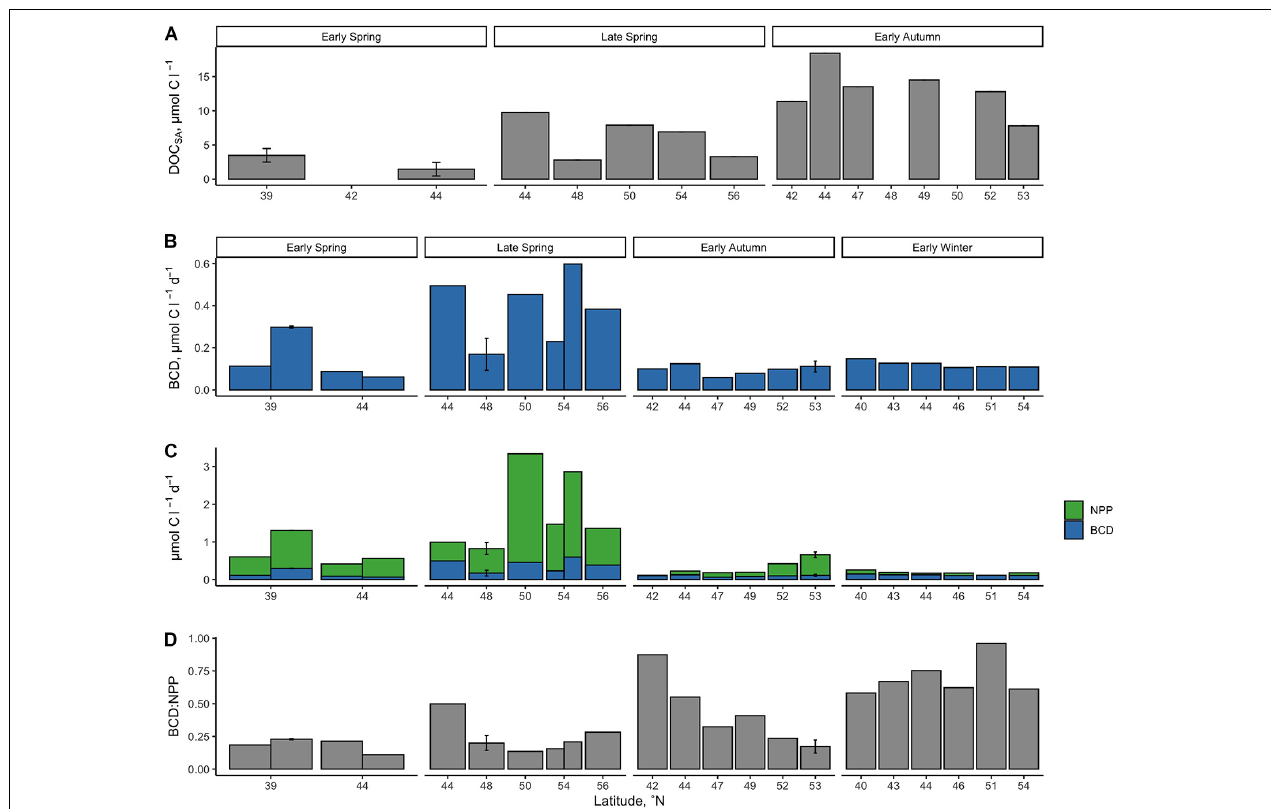
FIGURE 7 | Seasonally accumulated DOC from the initial condition of the DOC remineralization experiments, which were conducted using water from the surface at 10 m (A) . BGEs were applied to in situ measurements of net bacterio plankton production to estimate bacterioplankton carbon demand [BCD (B) ] and the fraction of NPP it represents (C,D) . Error bars represent standard